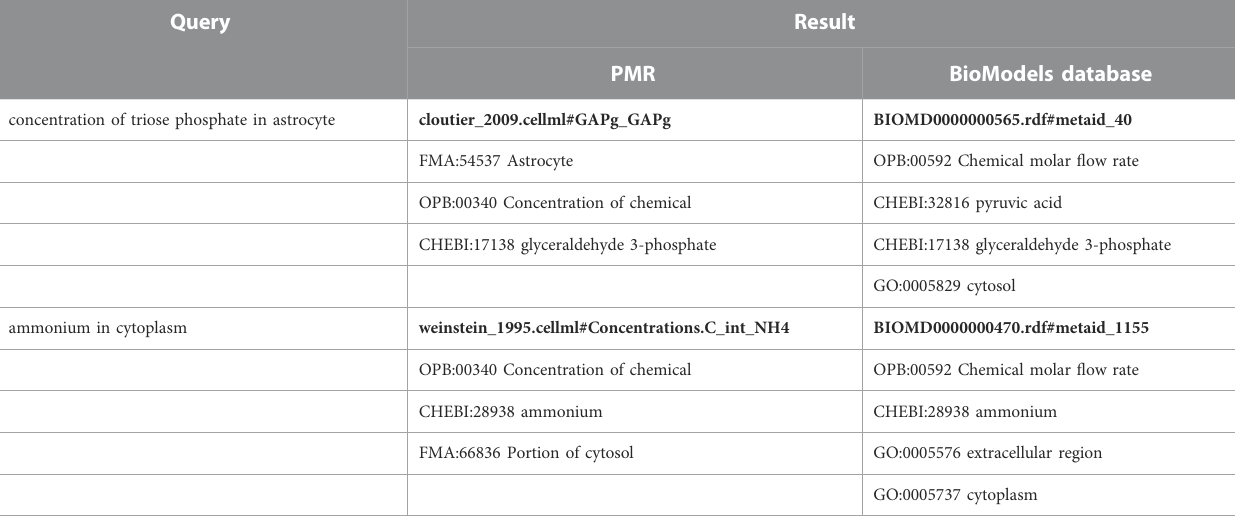
TABLE4Theexampleofentitiesretrievedfromdifferentrepositories,thePMRandtheBioModelsdatabase.Thoseentitieshavesimilaritiesintheontologyclasses related to the